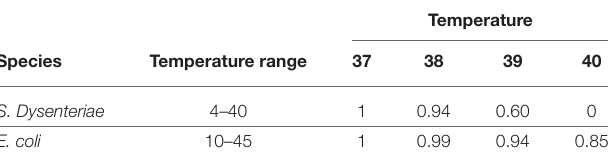
TABLE 1 | Relative growth ( T opt = 1) at febrile temperatures for S. dysenteriae and E. coli , modelled with the Ratkowsky